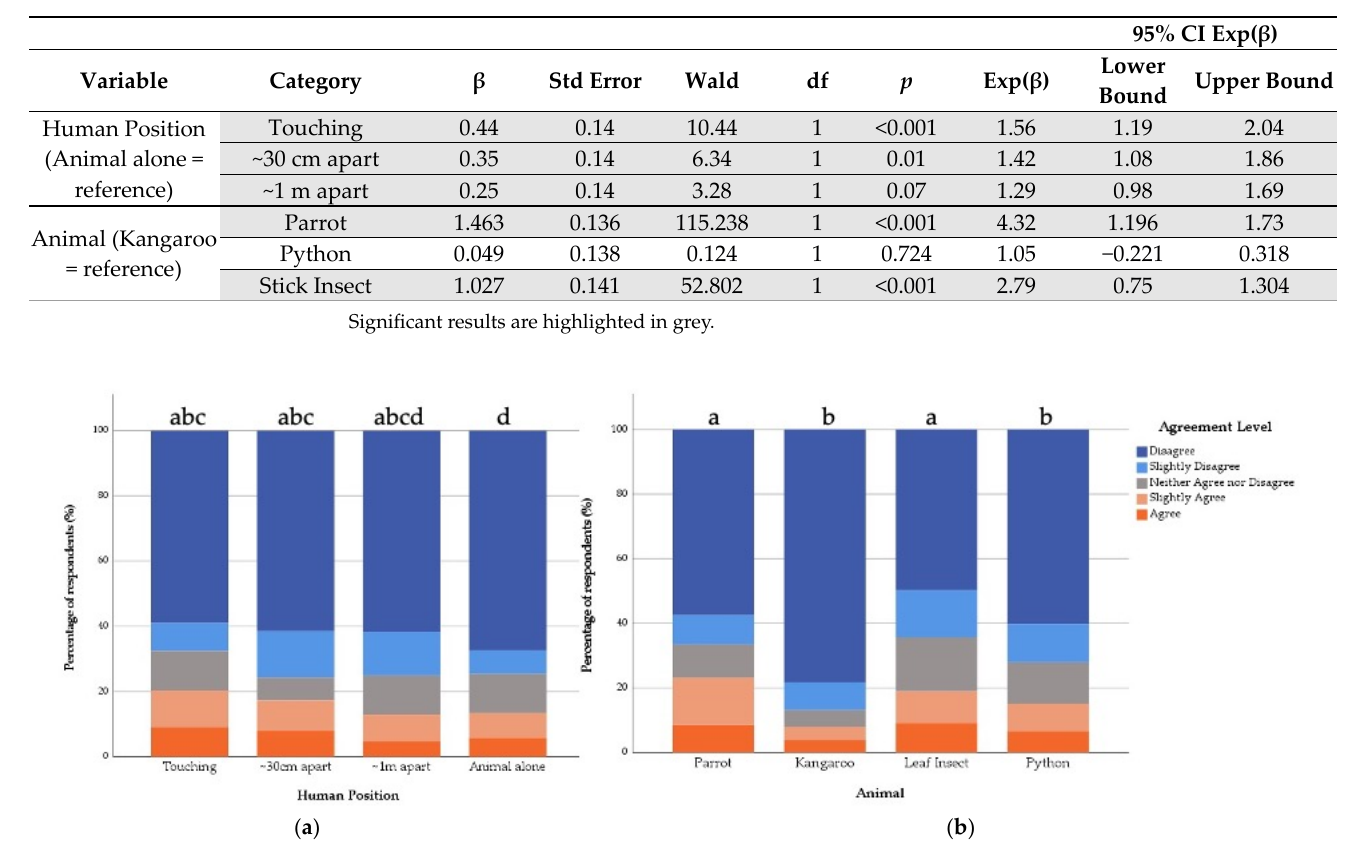
Figure 7. Percentage of General Public respondents’ agreement with the statement “the featured animal would make a good pet” in relation to the ( a ) Human Position shown and ( b ) Featured Animal shown. Same letters indicate no statistical difference and different letters indicate statistical differences between variables in the fitted model.